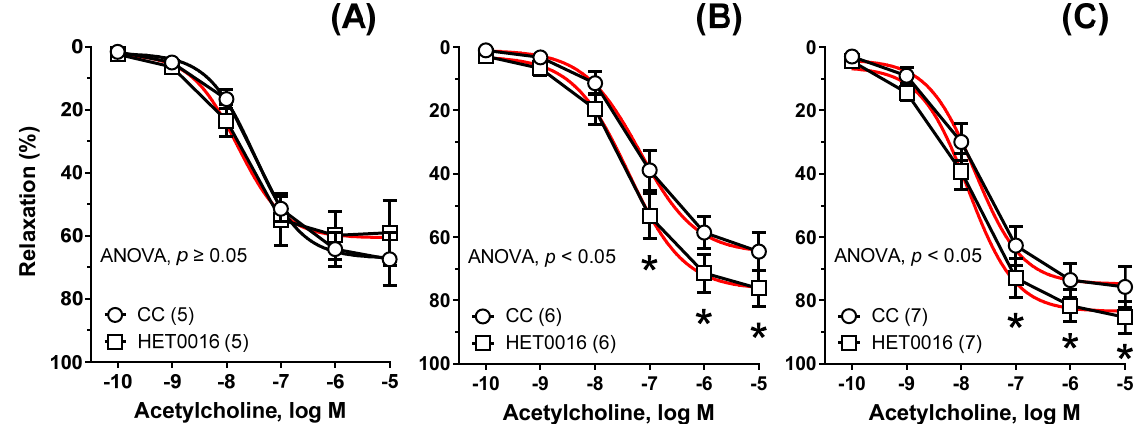
(AUC: ×1.39, Figure 6B), and NP 6.5 (AUC: ×1.52, Figure 6C) fed rats. This was not observed in the control group Cu 6.5 (AUC: ×1.02, Figure 6A).